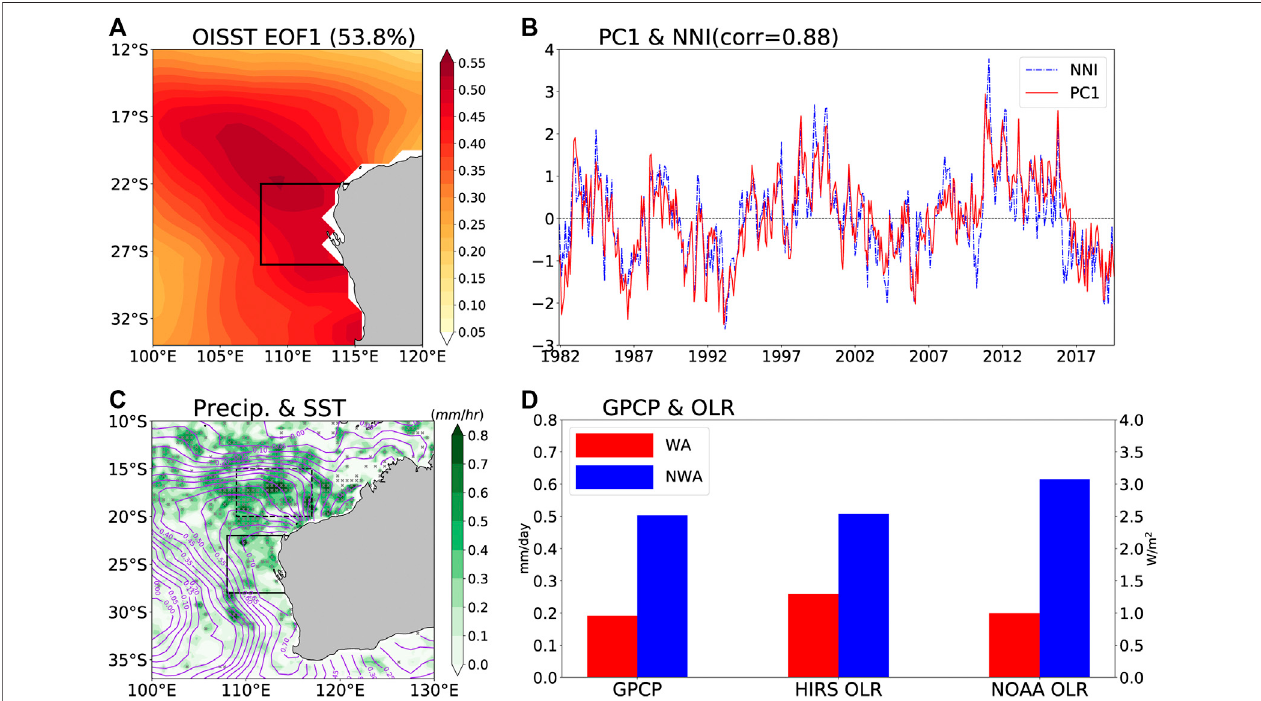
FIGURE 1 | (A) The fi rst EOF (EOF1) mode of the SST anomalies (shading: K) off WA during the period of 1981 – 2018 and (B) the normalized corresponding fi rst principalcomponent(PC1,redsolidcurve)andtheNingalooNiñoIndex(NNI,bluedashed curve)averagedfortheregion(108 ° E-coast,28 ° S – 22 ° S)markedbytheblack box in (A) . The correlation coef fi cient between PC1 and NNI is 0.88, which is statistically signi fi cant at the 99% level. (C) Austral summer (December-February) mean precipitation rate (shading: mm hr − 1 ) and SST anomalies (contour: K) obtained by regressing against PC1 during 1998 – 2013. The gray crosses indicate precipitation rate anomalies above the 90% signi fi cance level by a Student t test. The solid and dashed boxes indicate the WA (108 ° E-coast, 28 – 22 ° S) and NWA (109 – 117 ° E, 20 – 15 ° S) coastal regions, respectively. (D) Linear regression coef fi cients of the austral summer (DJF) mean PC1 with the GPCP precipitation (mm day − 1 ; 1981 – 2018), HIRS OLR (W m − 2 ; 1981 – 2018) and NOAA OLR (W m − 2 ; 1981 – 2013) averaged over the WA (red bars) and NWA (blue bars) coastal